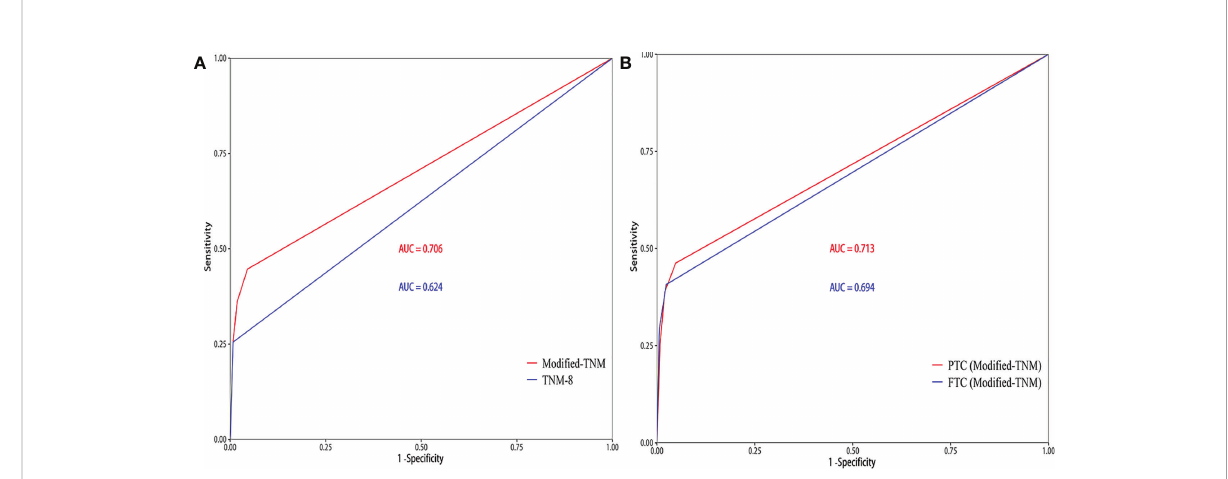
FIGURE 3 The area under the receiver operating characteristic curve (AUC) of the prediction model. (A) TNM-8 and the modi fi ed TNM staging system for patients younger than 55 years. (B) Performance of the modi fi ed TNM staging system when separately applied to papillary thyroid carcinoma (PTC) patients and follicular thyroid carcinoma (FTC) patients.